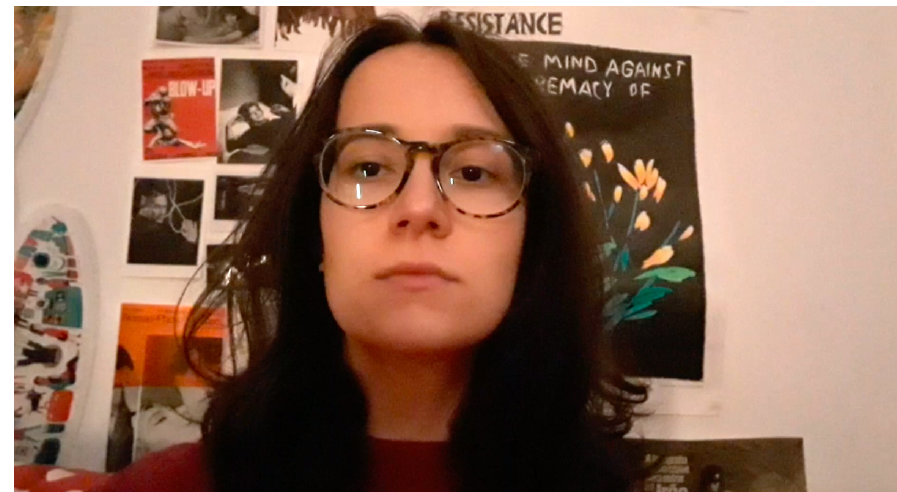
Figure 2. Film still from “From Here and There.” Source: Miranda